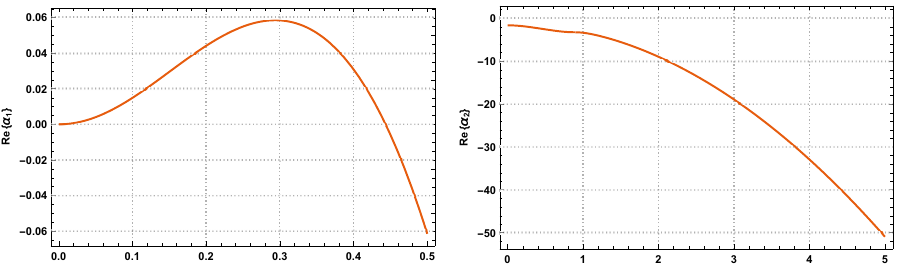
Figure 2. Plots of (cid:60) ( α 1 ) and (cid:60) ( α 2 ) versus wavenumber k for the laminar-flow model with h 0 = 2.5, u 0 = f 1 ( h 0 ) , a 1 = 1, and b = 11. While (cid:60) ( α 2 ) stays negative for all k , α 1 has a positive real part over a finite range of wavenumbers k near k = 0, exhibiting a maximum growth rate at a wavenumber close to 0.3.